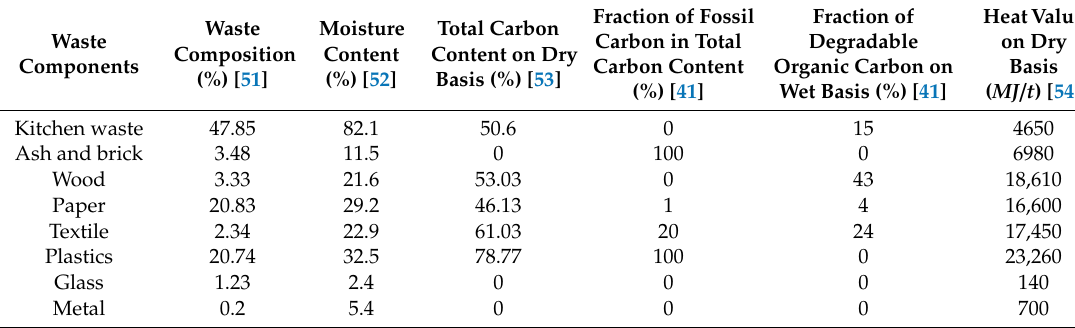
Table 1. MSW characteristics in Beijing.